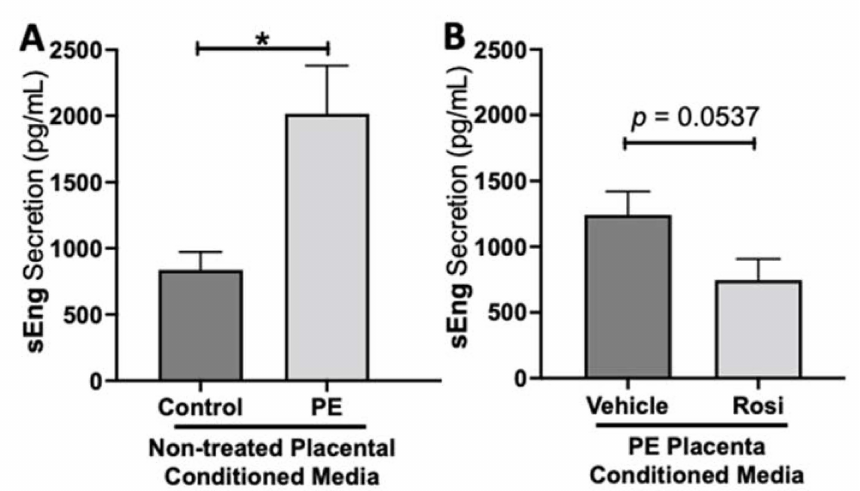
Figure 2. Soluble Endoglin secretion is increased in the preeclamptic placenta but reduced after Rosiglitazone treatment. Soluble Endoglin (sEng) levels were measured via Luminex assay from conditioned media from non-treated control and preeclamptic (PE) placentas ( A ) and vehicle- or Rosiglitazone (Rosi)-treated PE placentas ( B ). There was a significant upregulation of sEng secretion in PE compared to control placentas ( A , n > 10). Rosi-treated PE placentas show a reduction of sEng secretion however this was not statistically significant when compared to the vehicle control ( B , n = 14). (Protein secretion was measured by a Luminex assay where experimental values were determined relative to a standard curve. Statistical analysis was performed by student’s t -test to determine significant differences between groups, * p < 0.05, bar plots and data reported are reported as mean pg/mL values ±